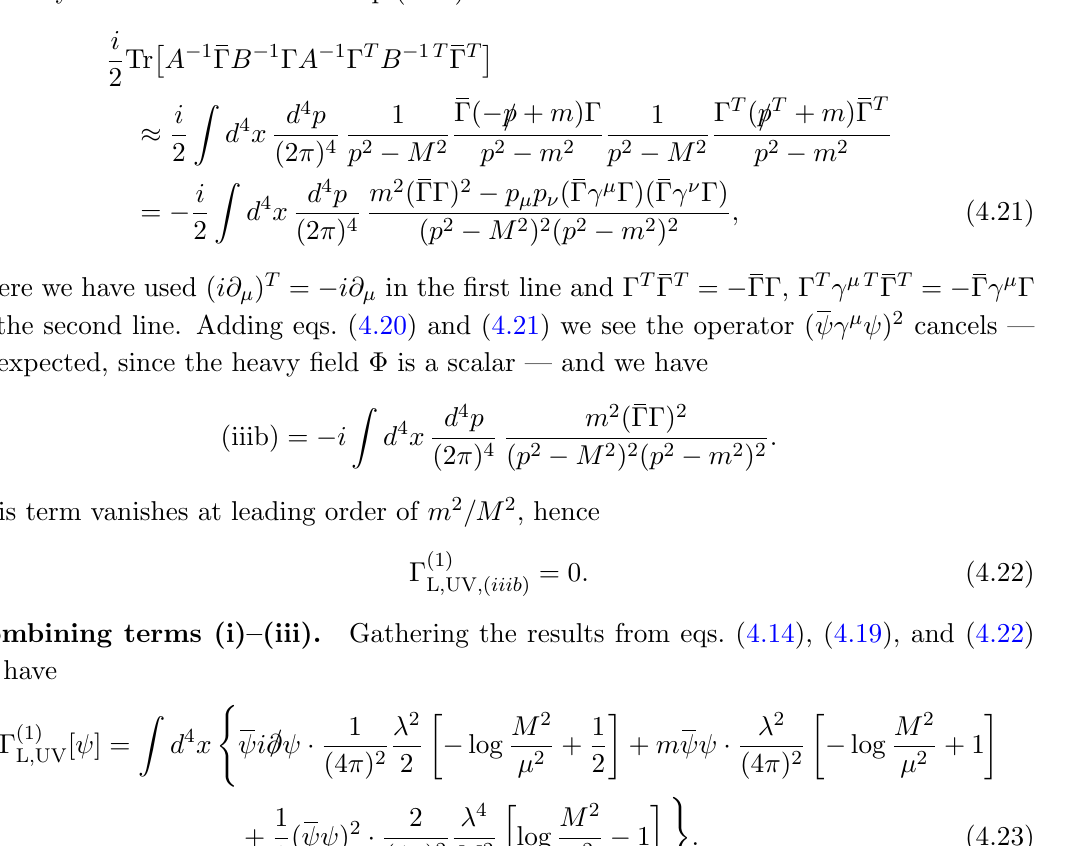
Similarly for the second term of eq.